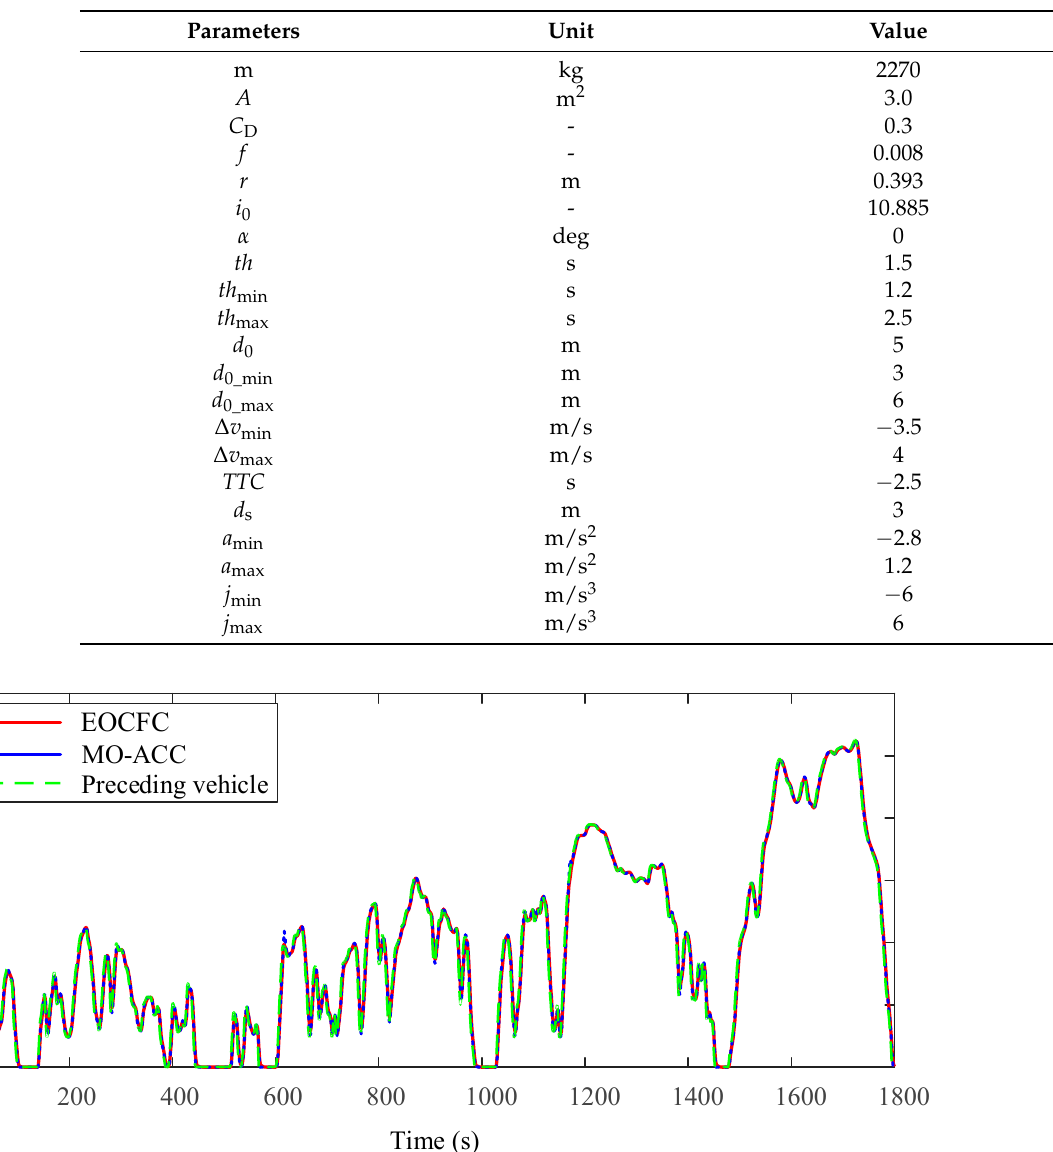
Table 1. Simulation parameters.